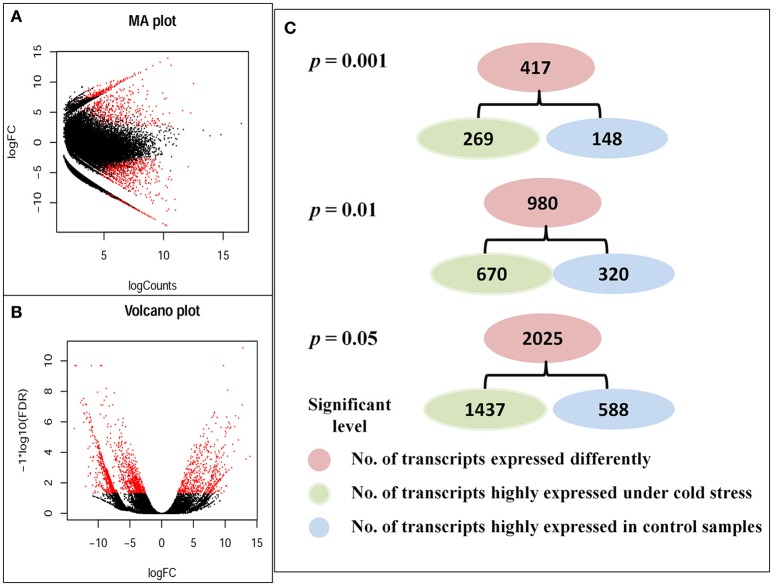
Differently expressed transcripts between control and cold stressed samples. (A) MA plot, (B) Volcano plot, and (C) Number of transcripts that expressed most differently at different significant levels. The red dots in MA and volcano plots indicated the transcripts that were differently expressed at least a fold change ratio of four (|log2FC| > 2) between control and cold stressed samples.